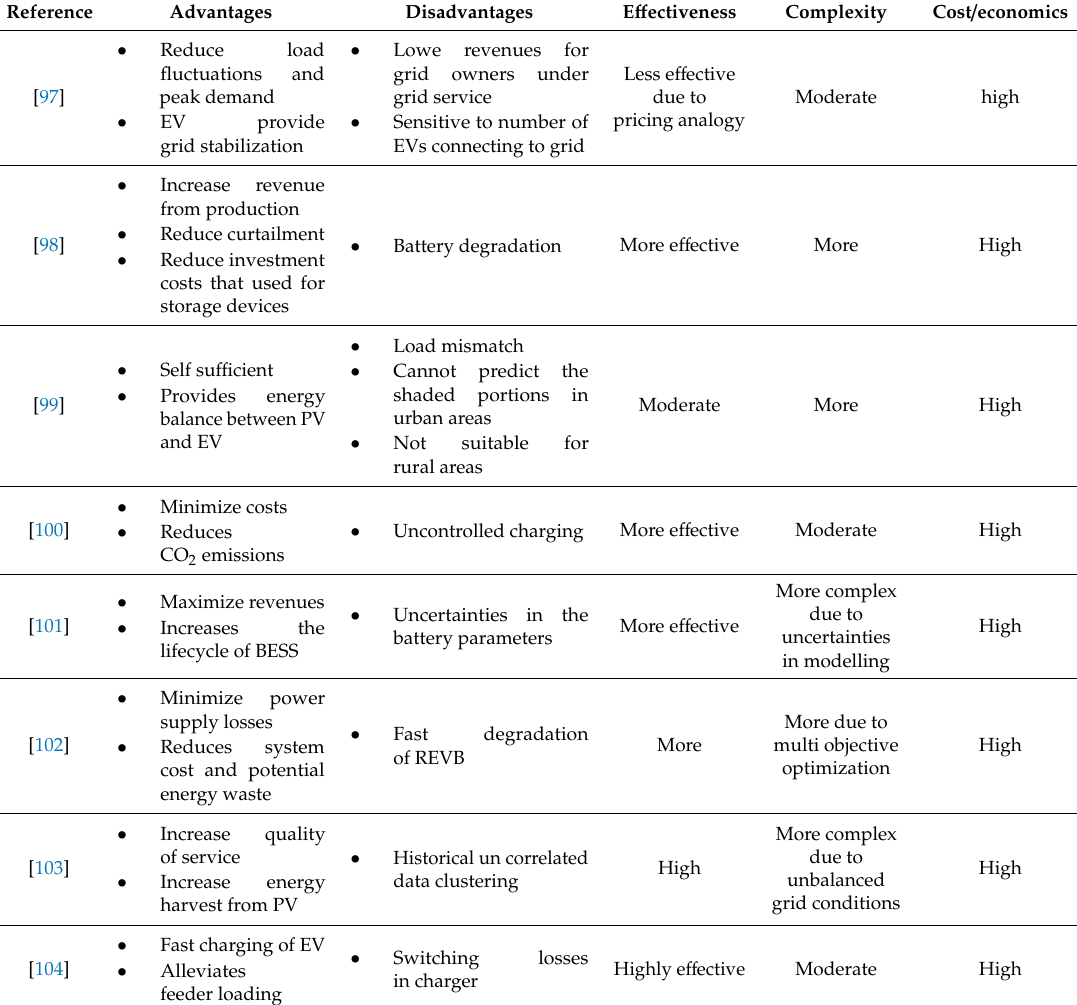
Table 1. Summary of the strategies involved for integration of PV power along with EVs.